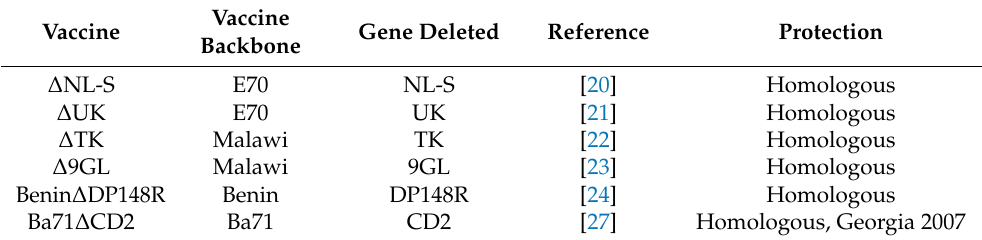
Table 1. Summary of initial vaccines against